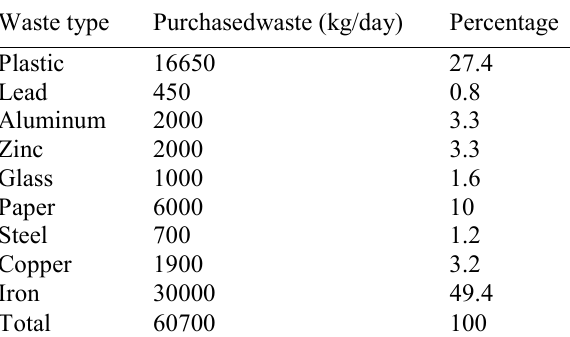
Table 6. Amount of waste incoming to workshops